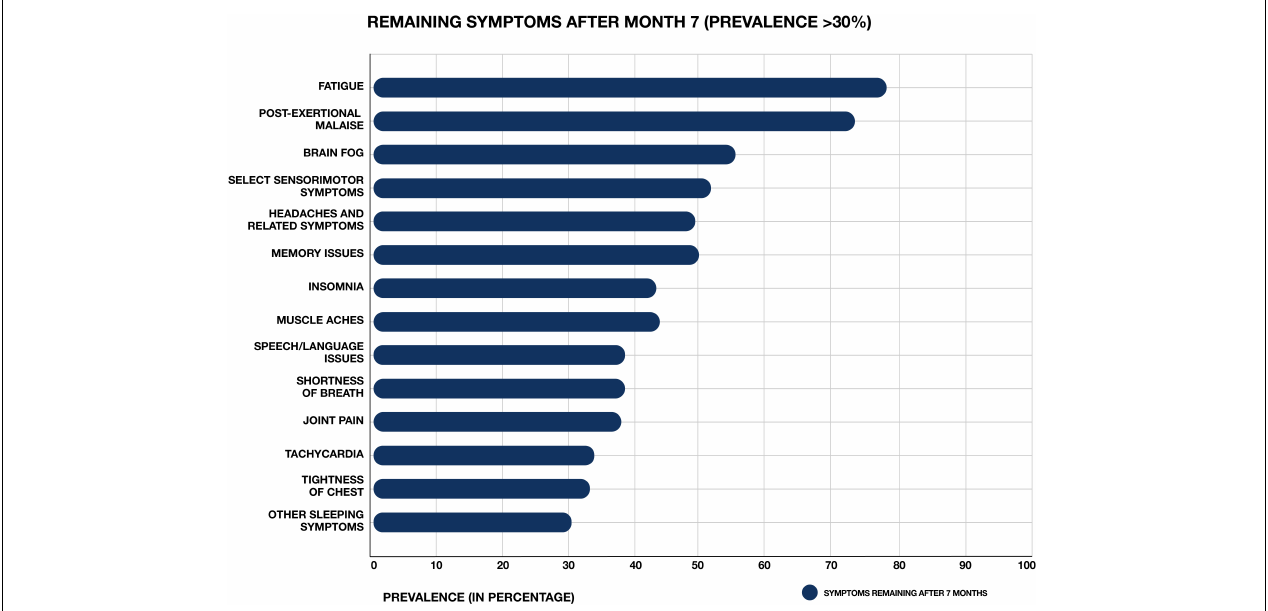
FIGURE 1 | Most common symptoms remaining after 7 months in 966 respondents from a cohort of suspected and confirmed COVID-19 cases. Results obtained via an international web-based survey. Image adapted with permission from Davis et al.